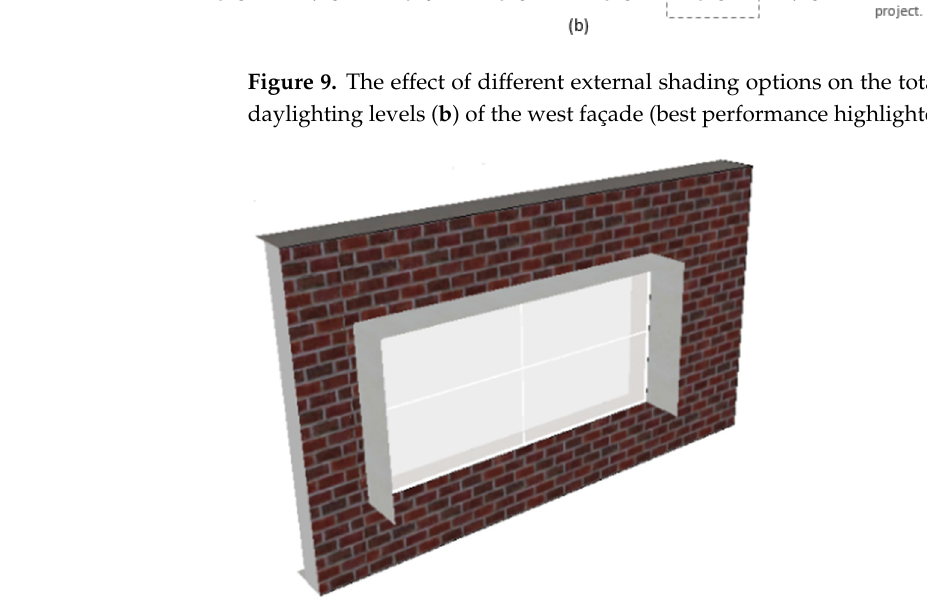
Figure 10. The best-performing external shading option of overhang and side fins with 0.8 m projection for the west façade existing